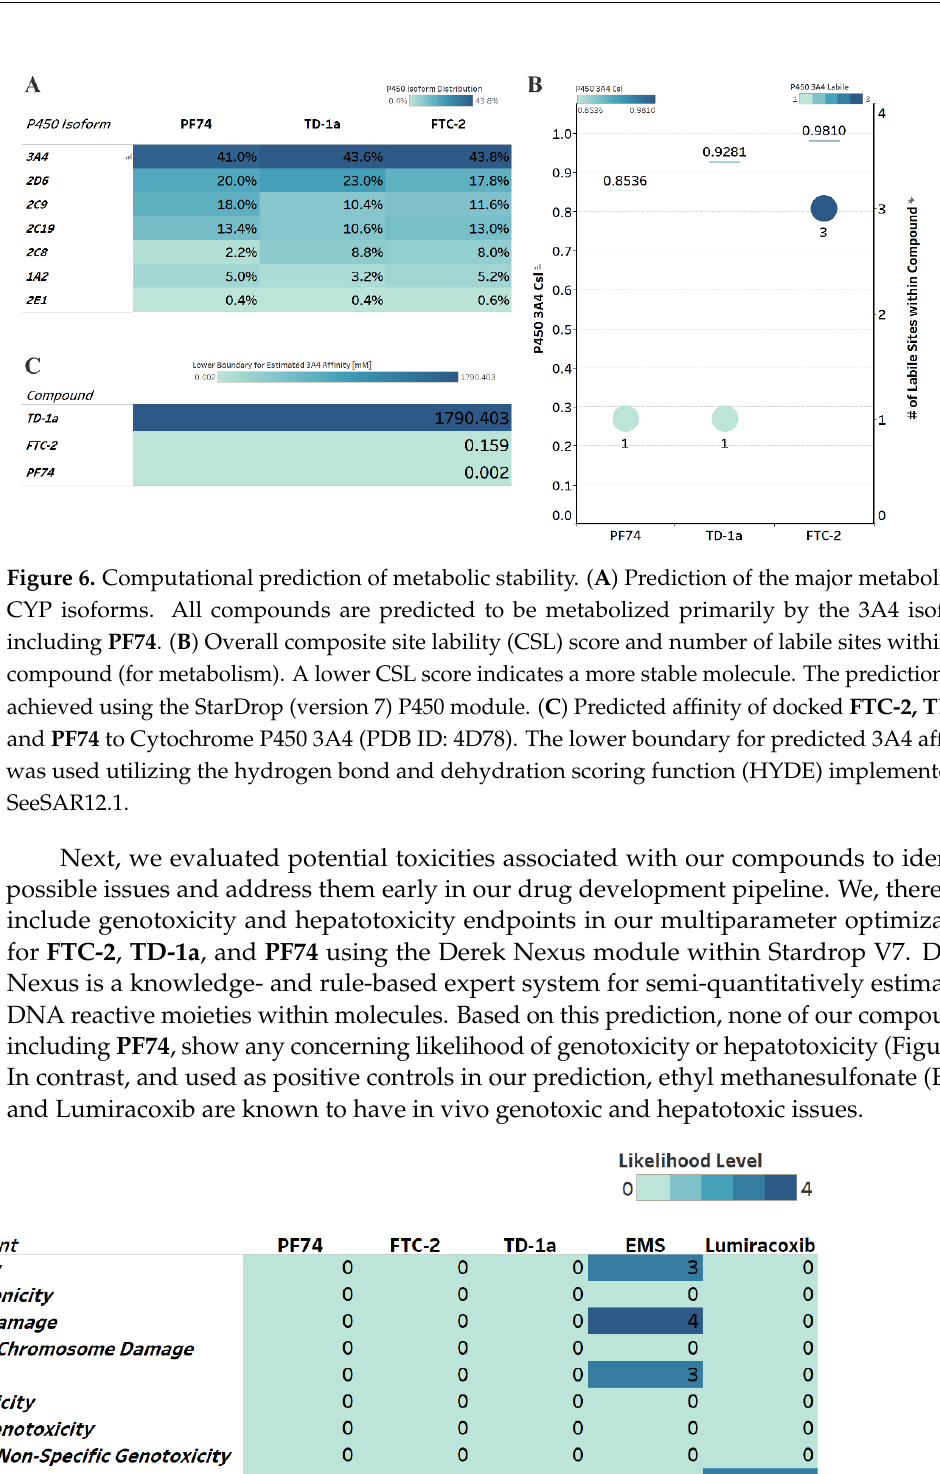
proved predicted metabolic stability. We employed a computational analysis first demon-